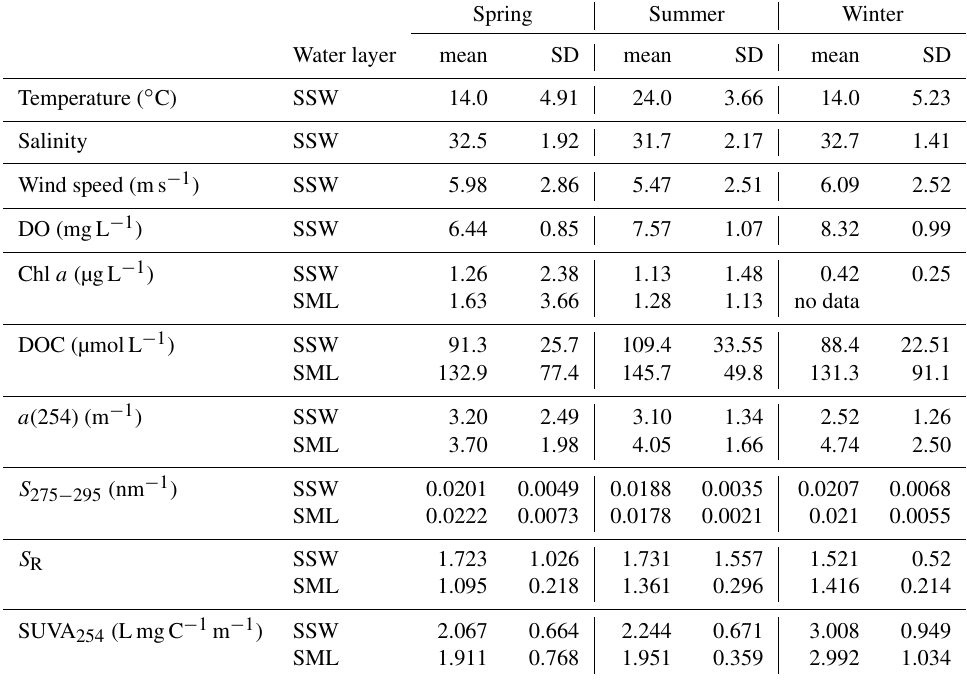
Table 2. Average temperature, salinity, wind speed, CDOM a (254), DOC, chlorophyll a (Chl a ), dissolved oxygen (DO), S 275 − 295 , S R and SUVA 254 of the SSW and SML in the YS and ECS during spring, summer and winter.